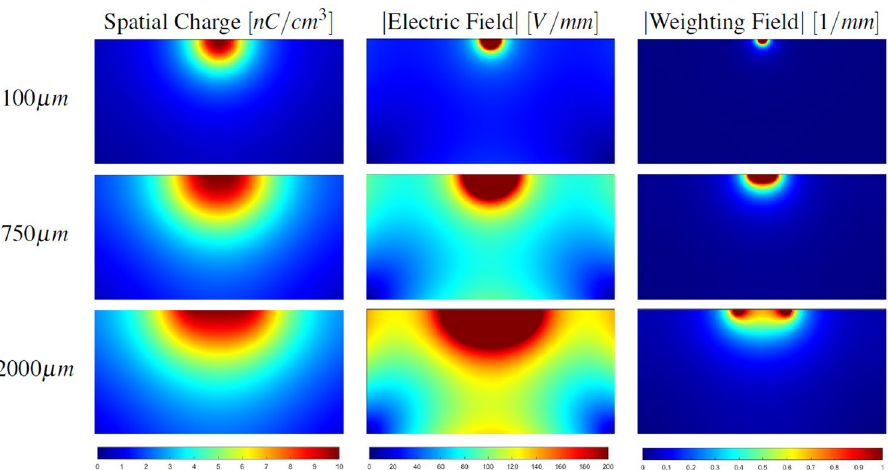
Figure 3. Space charge (left) Electric field (centre) and Weighting field (right) profiles evaluated on the YZ plane passing through the centre of the pixel are shown for 3 different pixel dimensions: 100 μm (top), 750 μm (centre), 2000 μm (bottom).